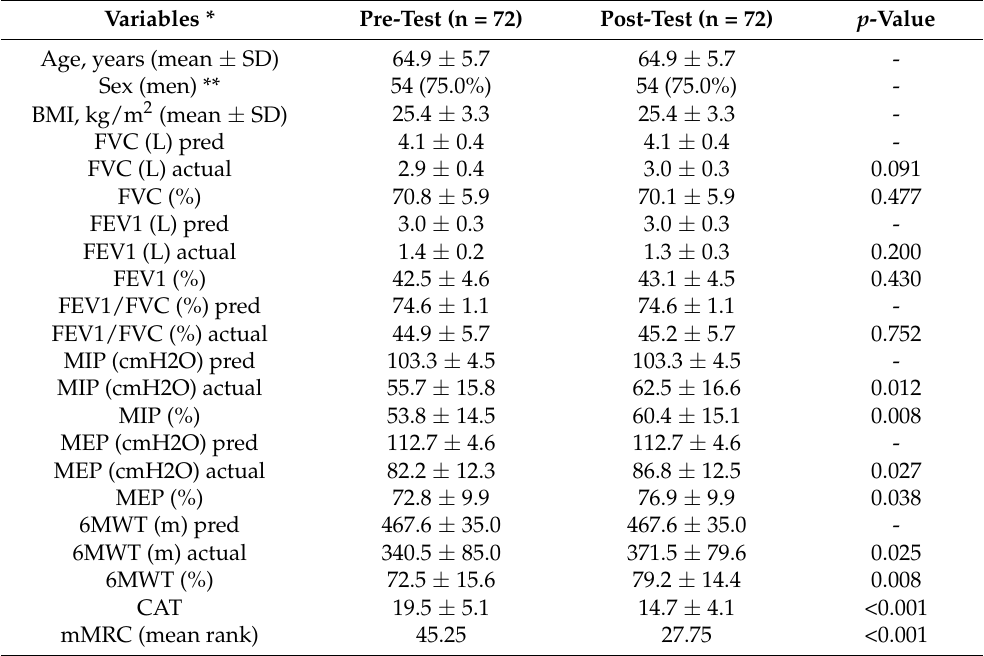
Table 1. Comparison of pre-test and post-test results in the inpatient setting.